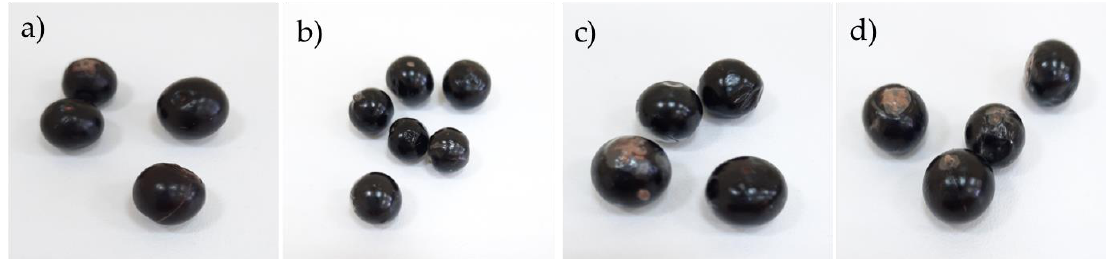
Figure 2. Images of Andean blueberries with and without coatings: ( a ) Control; ( b ) alginate; ( c ) alginate/cellulose nanofibrils (CNFs) 0.1%; and ( d ) alginate/CNFs 0.3%.